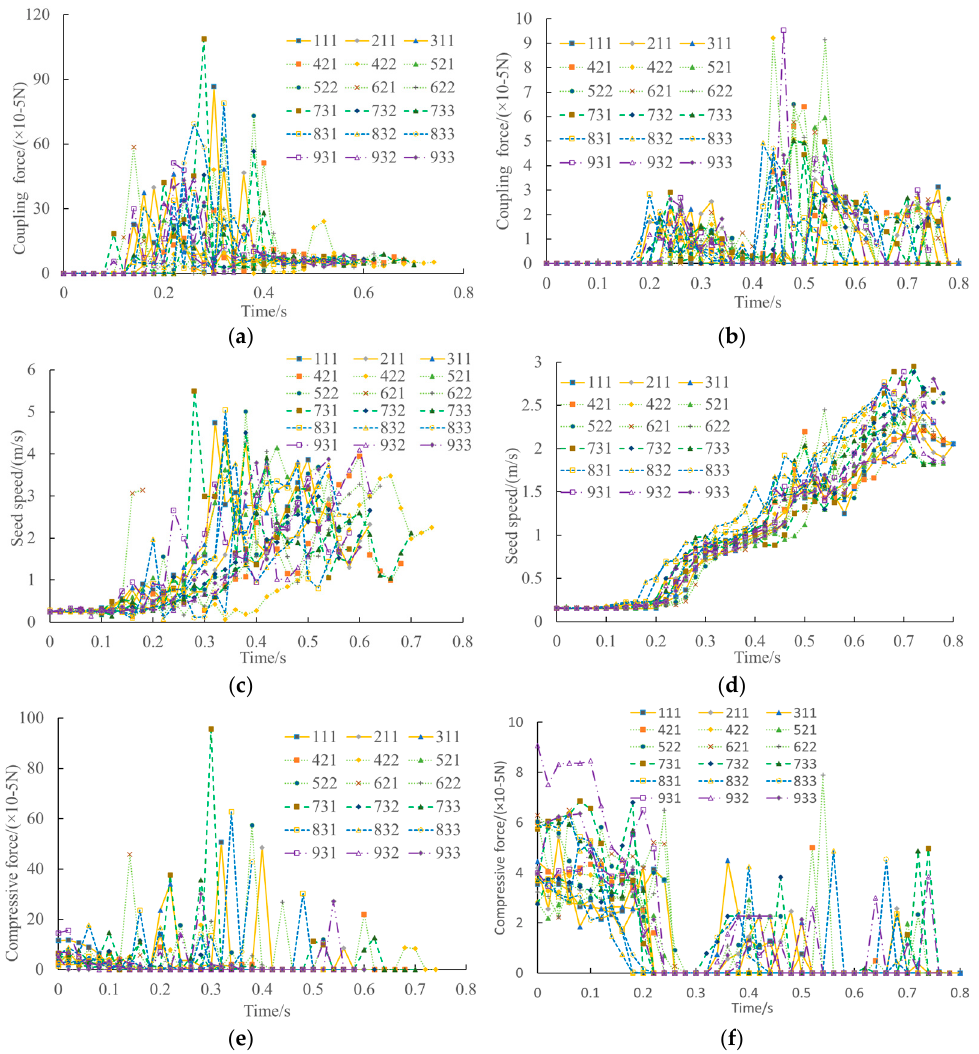
Figure 12. Force and velocity of seeds in guiding process: ( a ) coupling force in test 3; ( b ) coupling force in optimal result; ( c ) velocity in test 3; ( d ) velocity in optimal result; ( e ) compressive force in test 3; ( f ) compressive force in optimal result.